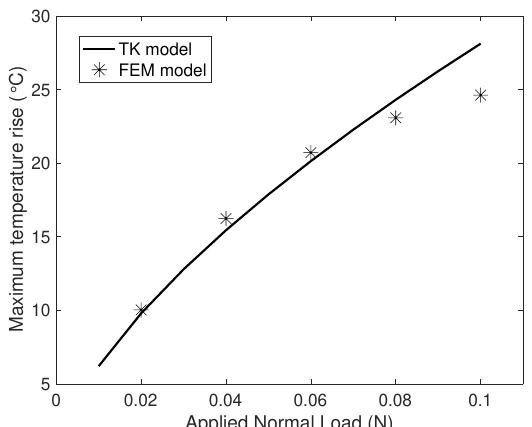
Figure 2 . Maximum temperatures estimated from the theoretical (TK) model and the FEM model at various applied normal loads .